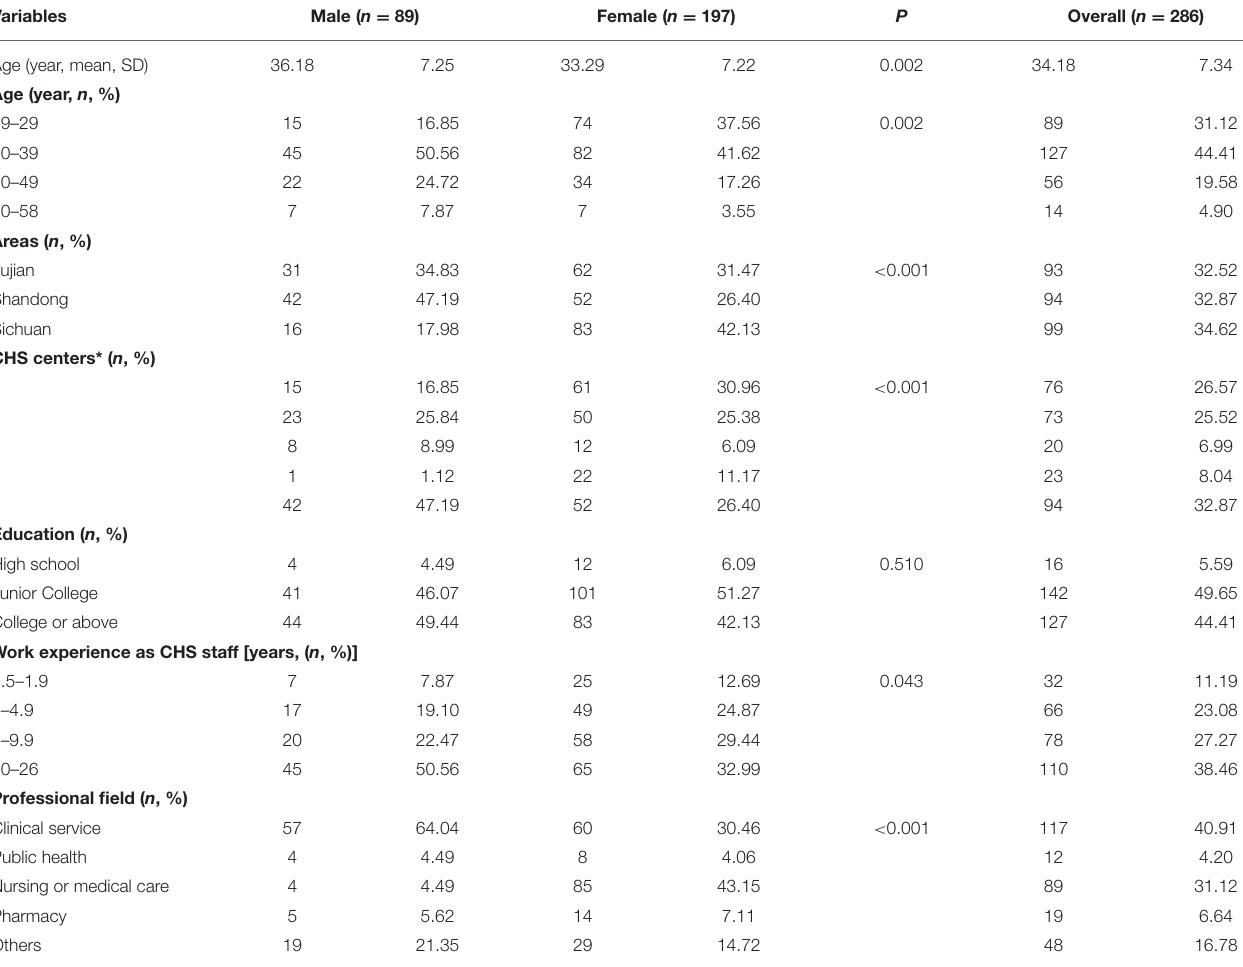
TABLE 2 | Sociodemographic and professional characteristics of study participants from five community health service centers in China, 2016.